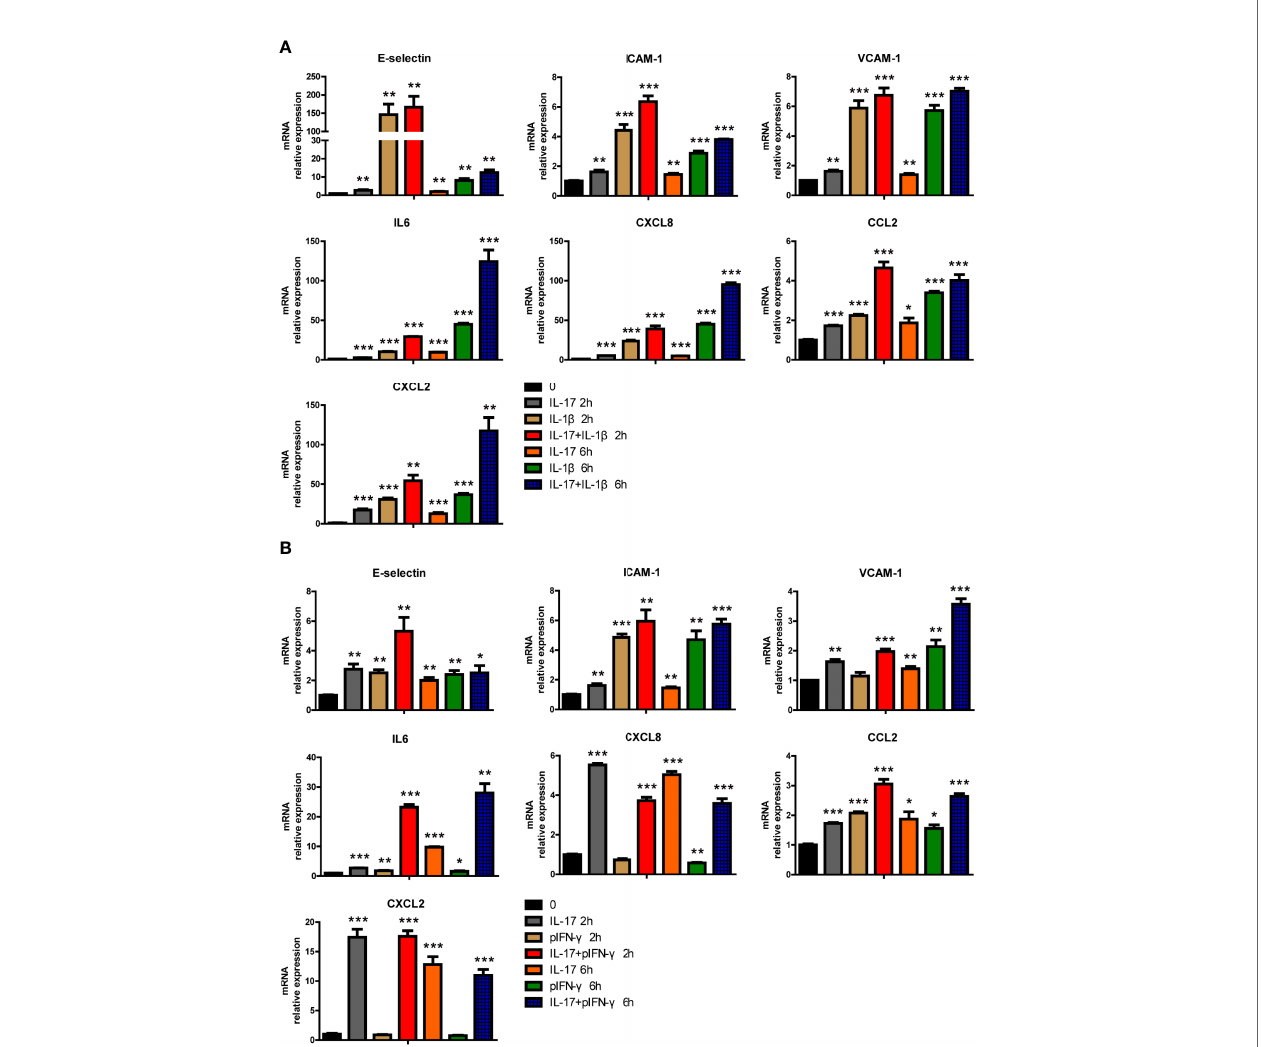
FIGURE 7 | IL-17 and IL-1 b or IFN- g additively or synergistically induced the expression of certain proin fl ammatory genes in porcine aortic endothelial cells (PAECs). (A) The PAECs were treated with rhIL-17 (50 ng/ml), rhIL-1 b (10 ng/ml), or rhIL-17 plus rhIL-1 b for 0, 2, or 6 h. The induction of E-selectin, VCAM-1, ICAM-1, IL-6, IL-8, MCP-1, or CXCL2 mRNA was measured using real-time PCR. (B) The PAECs were treated with rhIL-17 (50 ng/ml), rpIFN- g (40 ng/ml), or rhIL-17 plus rpIFN- g for 0, 2, or 6 h. The induction of E-selectin, VCAM-1, ICAM-1, IL-6, IL-8, MCP-1, or CXCL2 mRNA was measured using real-time PCR. Data are representative of at least three independent experiments (mean ± SEM). * p < 0.05, ** p < 0.01, *** p < 0.001, determined by Student ’ s t